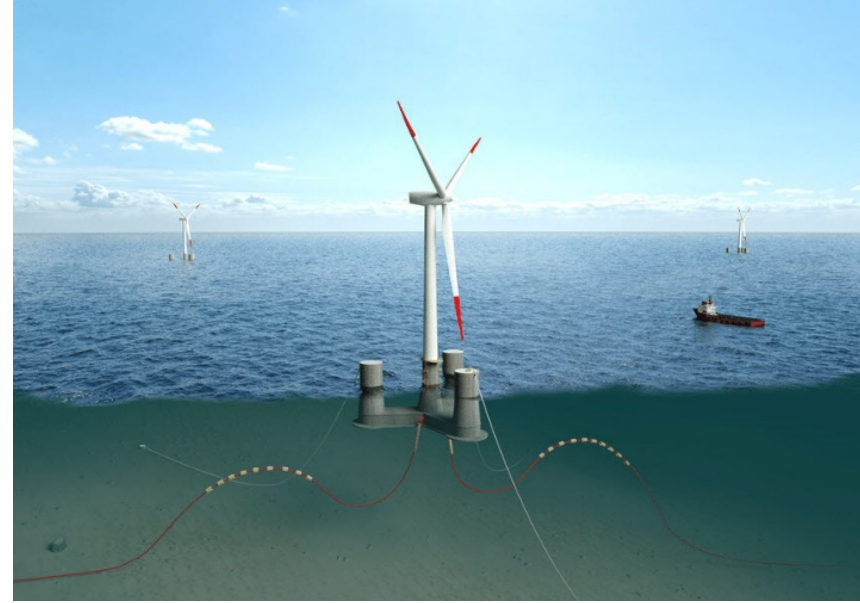
Figure 1. LIFES50+ OO-Star Wind Floater Semi 10 MW.